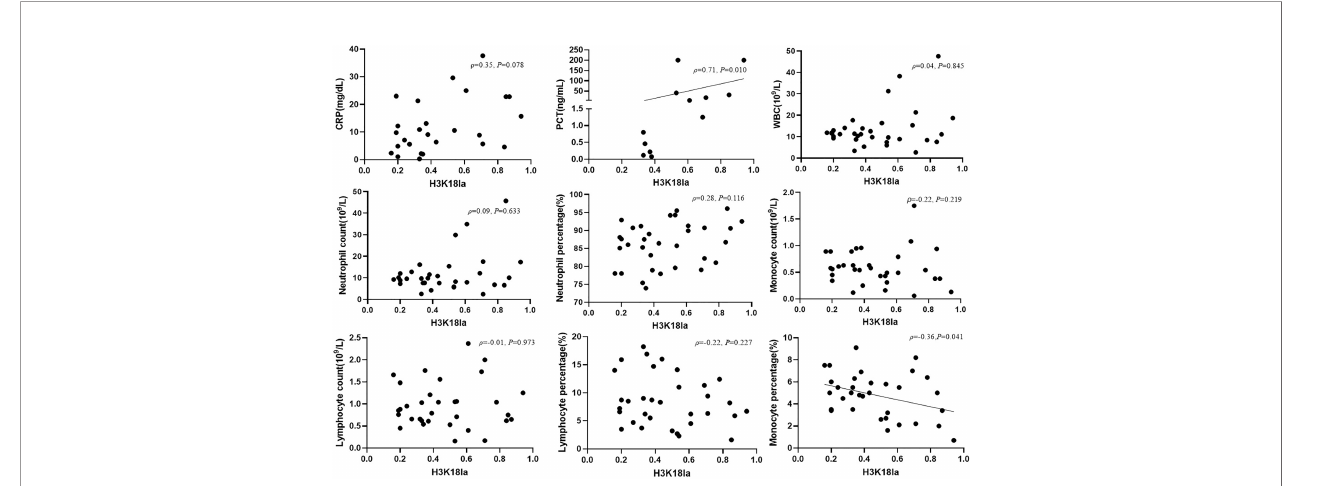
FIGURE 5 | H3K18la lactylation correlation with infectious laboratory parameters. Protein expression of H3K18la has a positive correlation with the serum level of PCT (Spearman correlation coef fi cient 0.71, P =0.010) and has a negative correlation with monocyte percentage (Pearson correlation coef fi cient -0.36, P =0.041). PCT, procalcitonin; CRP, C-reactive protein; WBC, white blood count. P values below 0.05 indicate statistical signi fi